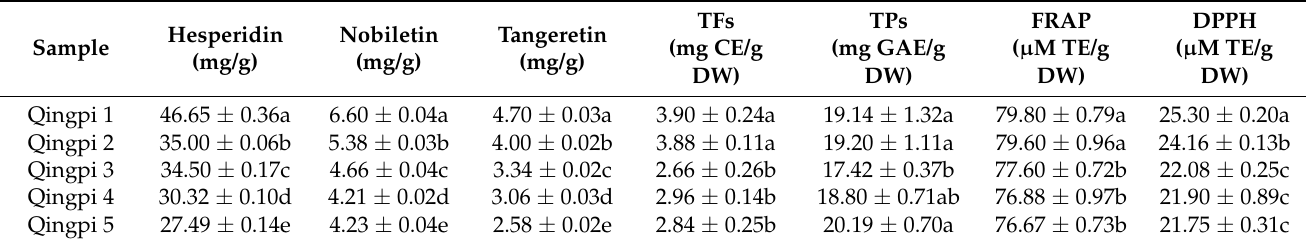
Table 2. Levels of hesperidin, nobiletin, tangeretin, TFs, and TPs and the antioxidant activity of Qingpi during storage (mean ± SD, n =